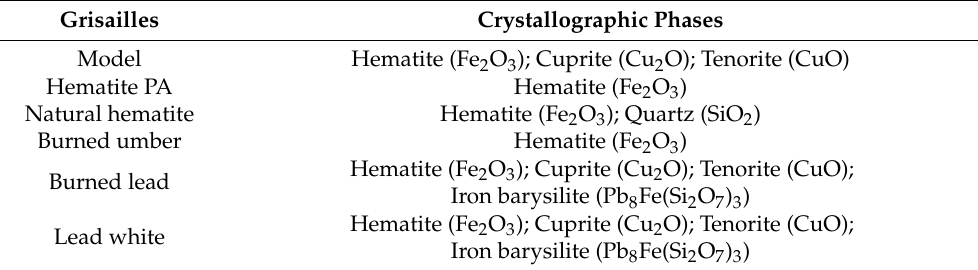
Table 5. Crystallographic phases of selected grisaille samples obtained by XRD.